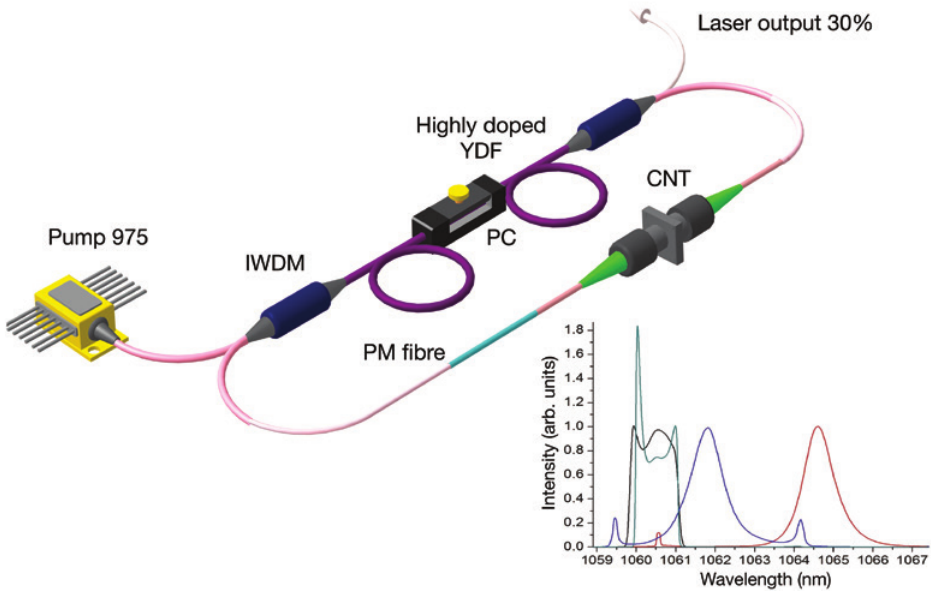
Figure 15: Yb-doped fibre laser setup. YDF, Ytterbium-doped fibre; IWDM, isolating wavelength division multiplexor; PC, polarization con- troller; PM, polarisation-maintaining fibre. Inset: Central wavelength tuning. Adapted from [51].